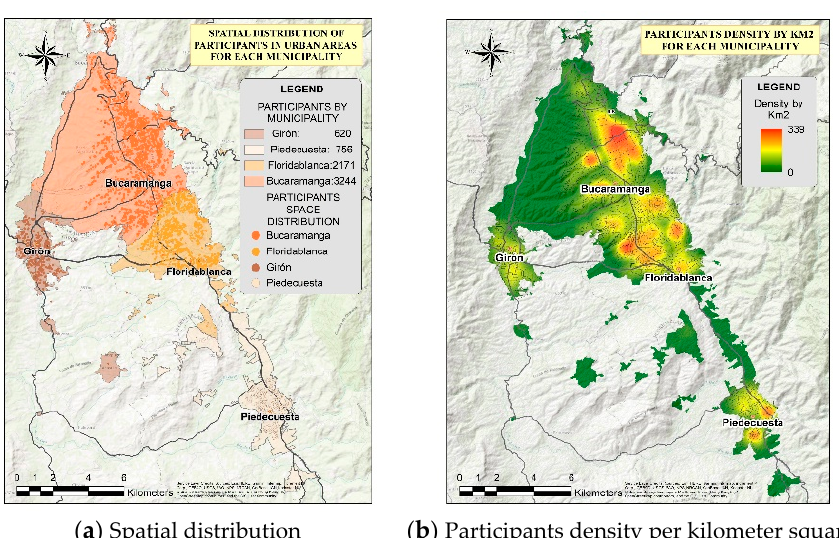
Figure 2. Participants’ geolocation in the Bucaramanga metropolitan area. ( a ) Spatial distribution of participants and density per kilometer squared in urban areas for the municipalities of the Bucaramanga metropolitan area. ( b ) Participant density per kilometer squared for each municipality.